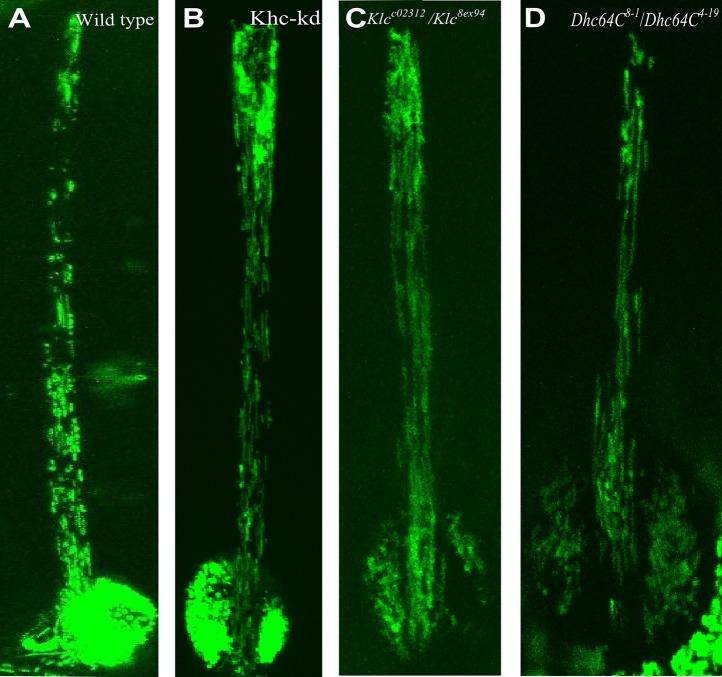
Bristle mitochondria distribution shows no detectable defects in Khc-kd, Klc and Dhc64C mutants. Confocal projections of bristles expressing mitochondria marker, UAS-GFP-Mito from wild type (A), Khc-RNAi; neur-Gal4 (B), Klcc02312/Klc8ex94 (C) and Dhc64C8-10/Dhc64C4-19 (D). The mitochondria localization pattern shows a similar wild-type distribution in Khc-kd, Klc and Dhc64C mutants.